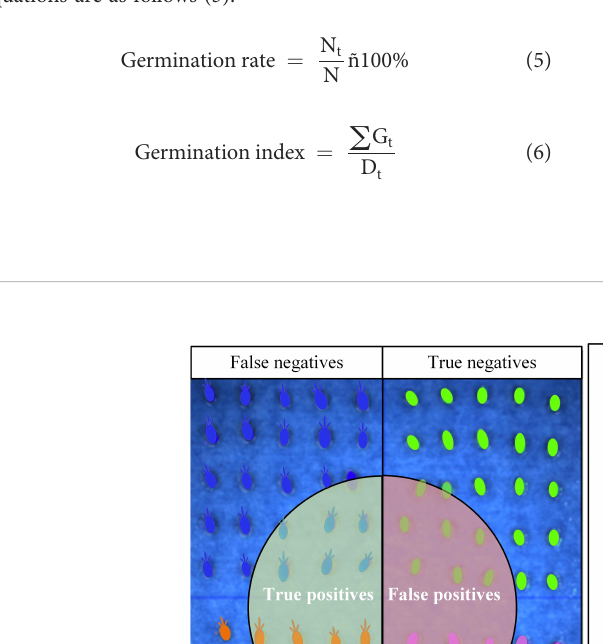
FIGURE 6 Comparison of the total number of detected targets for the three models on the four test sets. test01, test02, test03 and test04 represent the test set data of the early stage, middle stage, late stage and test set data of seed germination after data enhancement, respectively, to obtain the actual total number of germinating seed targets (GT, the Ground truth) and the total number of detected targets. The number of pictures of each test set is represented in parentheses.